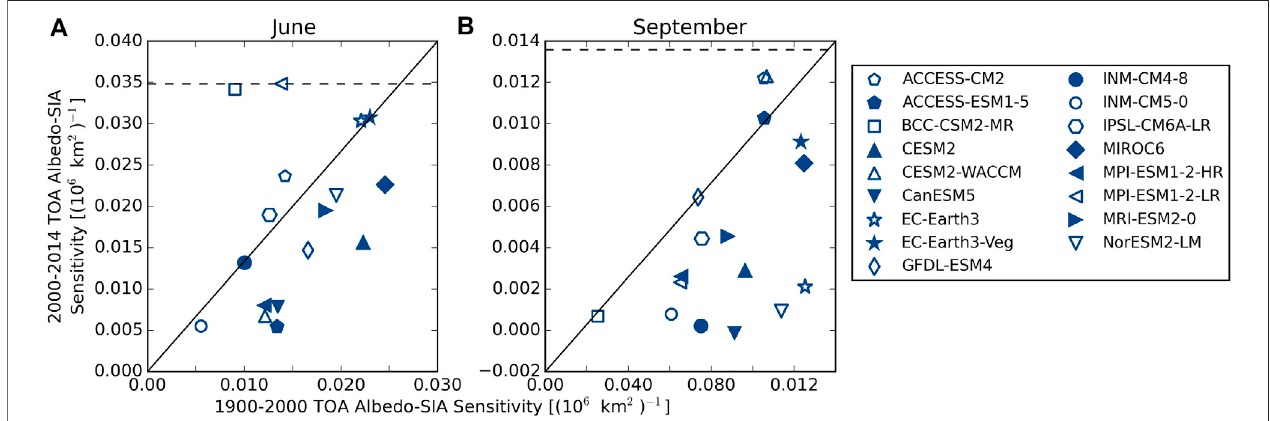
FIGURE 6 | Sensitivity of TOA albedo to SIA in CMIP6 calculated over 1900 – 2005 compared to 2000 – 2014 for June (A) and September (B) . Sensitivity from CERES over 2000 – 2014 is plotted as the horizontal line for reference.